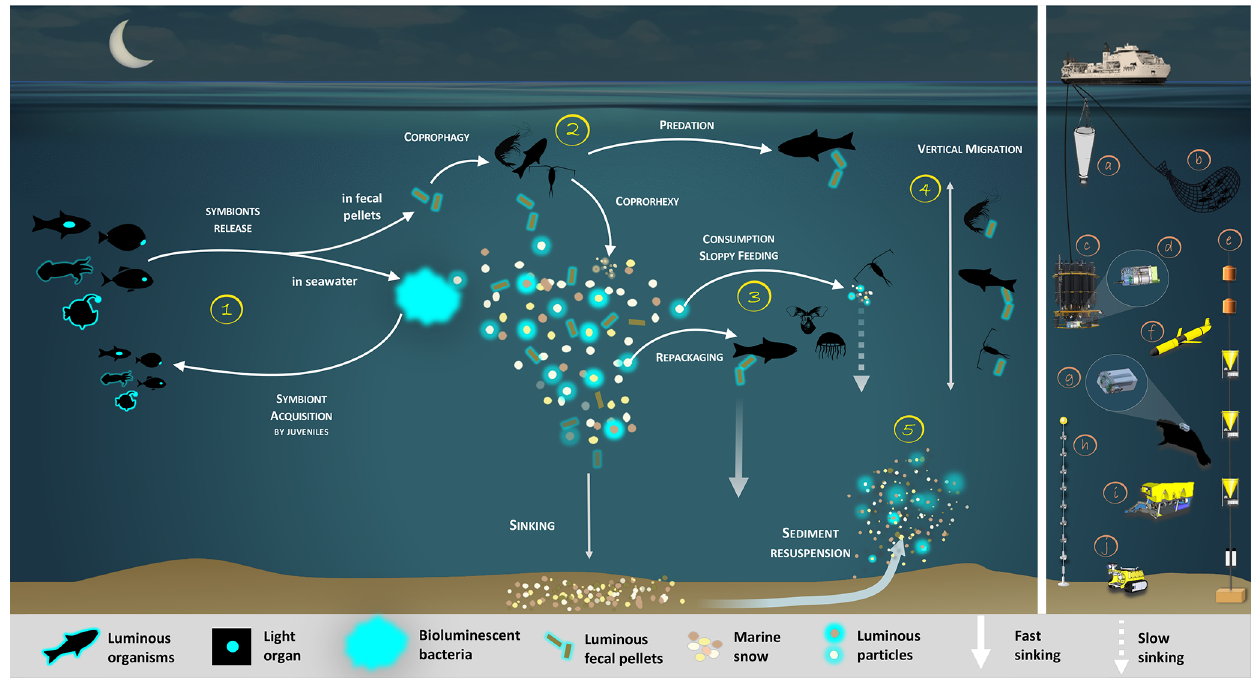
Figure 1. Bioluminescence shunt in the biological carbon pump in the ocean. Luminous bacteria in light organ symbioses are successively acquired by host (squid, fish) from the seawater while they are juveniles, then regularly released into the ocean. Depending on the light organ position, luminous bacteria are released from their guts into fecal pellets or directly into the seawater (step 1). Motile luminous bacteria colonize organic matter sinking along the water column. Bioluminescent bacteria inseminating fecal pellets and particles influence zooplankton consumption rates. Such visual markers increase detection (“bait hypothesis”), attraction and finally predation by upper trophic levels (step 2). In the mesopelagic, zooplankton and their predators feed on sinking luminous particles and fecal pellets, which form either aggregates (repackaging) of faster sinking rates or fragment organic matter (due to sloppy feeding) with slower sinking rates (step 3). Filter feeders also aggregate sinking organic matter without particular visual detection and selection of luminous matter. Diel (and seasonal) vertical migrators feeding on luminous food metabolize and release glowing fecal pellets from the surface to the mesopelagic zone (step 4). This implies bioluminescent bacteria dispersion at large spatial scales, for zooplankton or even some fish actively swimming long distances. Luminous bacteria attached to particles sink down to the seafloor, and sediment can be resuspended by oceanographic physical conditions (step 5) and consumed by epi-benthic organisms. Instruments are (a) plankton net, (b) fish net, (c) Niskin water sampler, (d) bathyphotometer, (e) sediment traps, (f) autonomous underwater vehicles, (g) photomultiplier module, (h) astrophysics optical modules ANTARES and (i– j) remotely operated